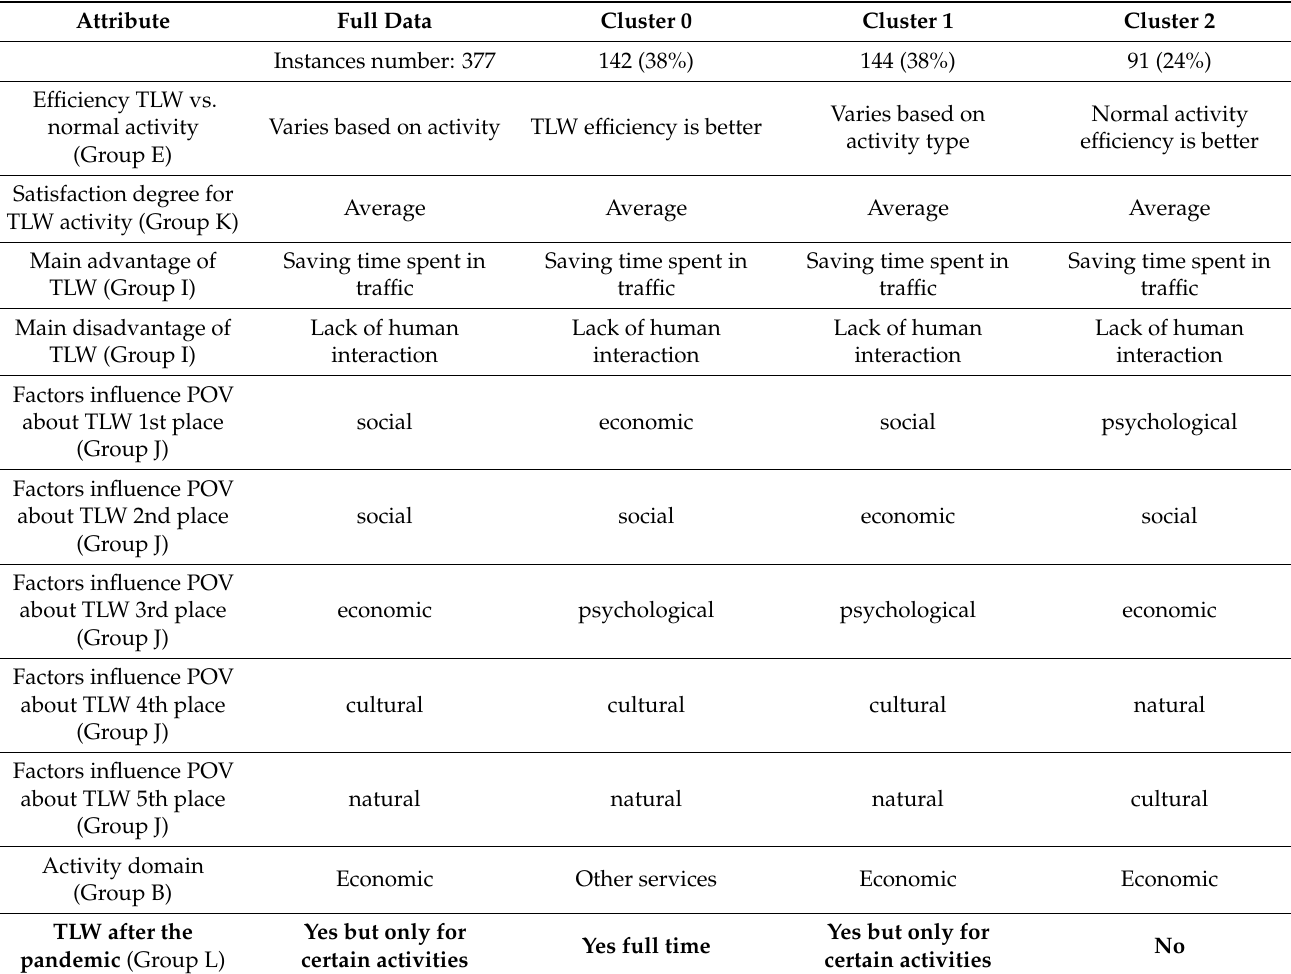
Table 5. Cluster analysis of impact of teleworking after the